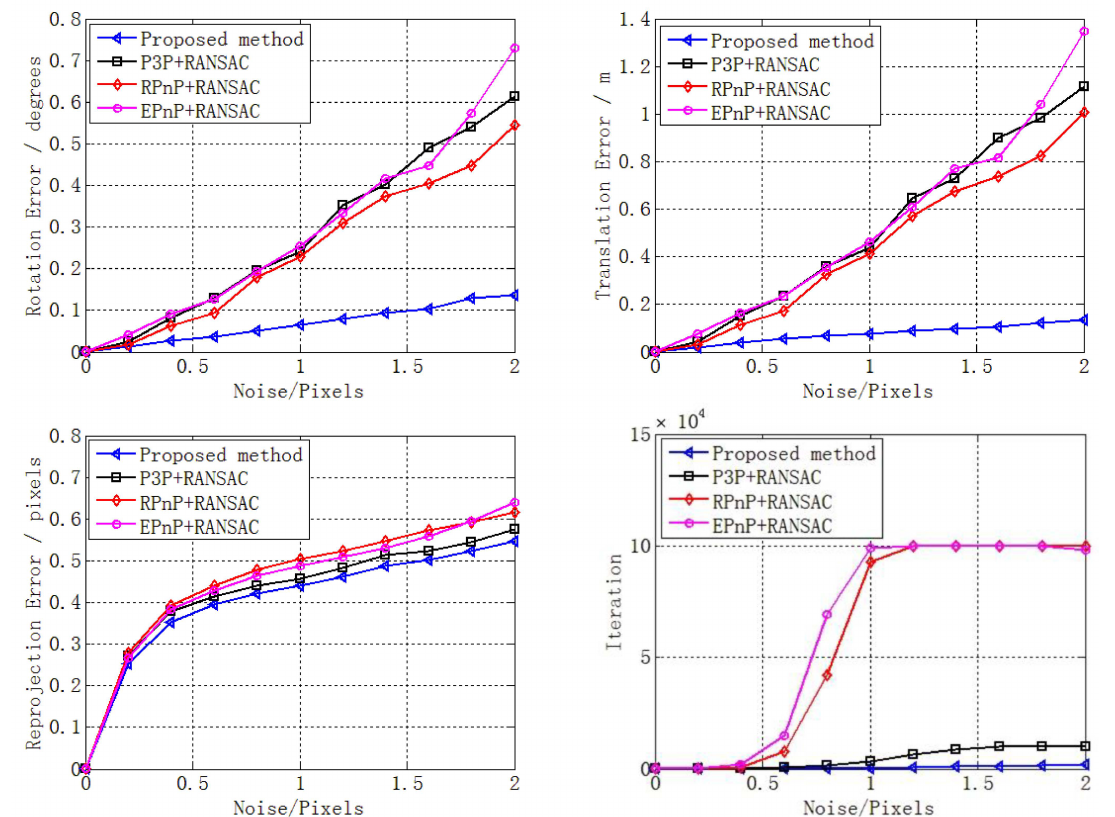
Figure 9. Noise sensitivity in terms of rotation error ( top left ), translation error ( top right ), reprojec- tion error ( bottom left ), and iteration ( bottom right ) for our proposed method (blue), P3P + RANSAC (black), RPnP + RANSAC (red), and EPnP + RANSAC